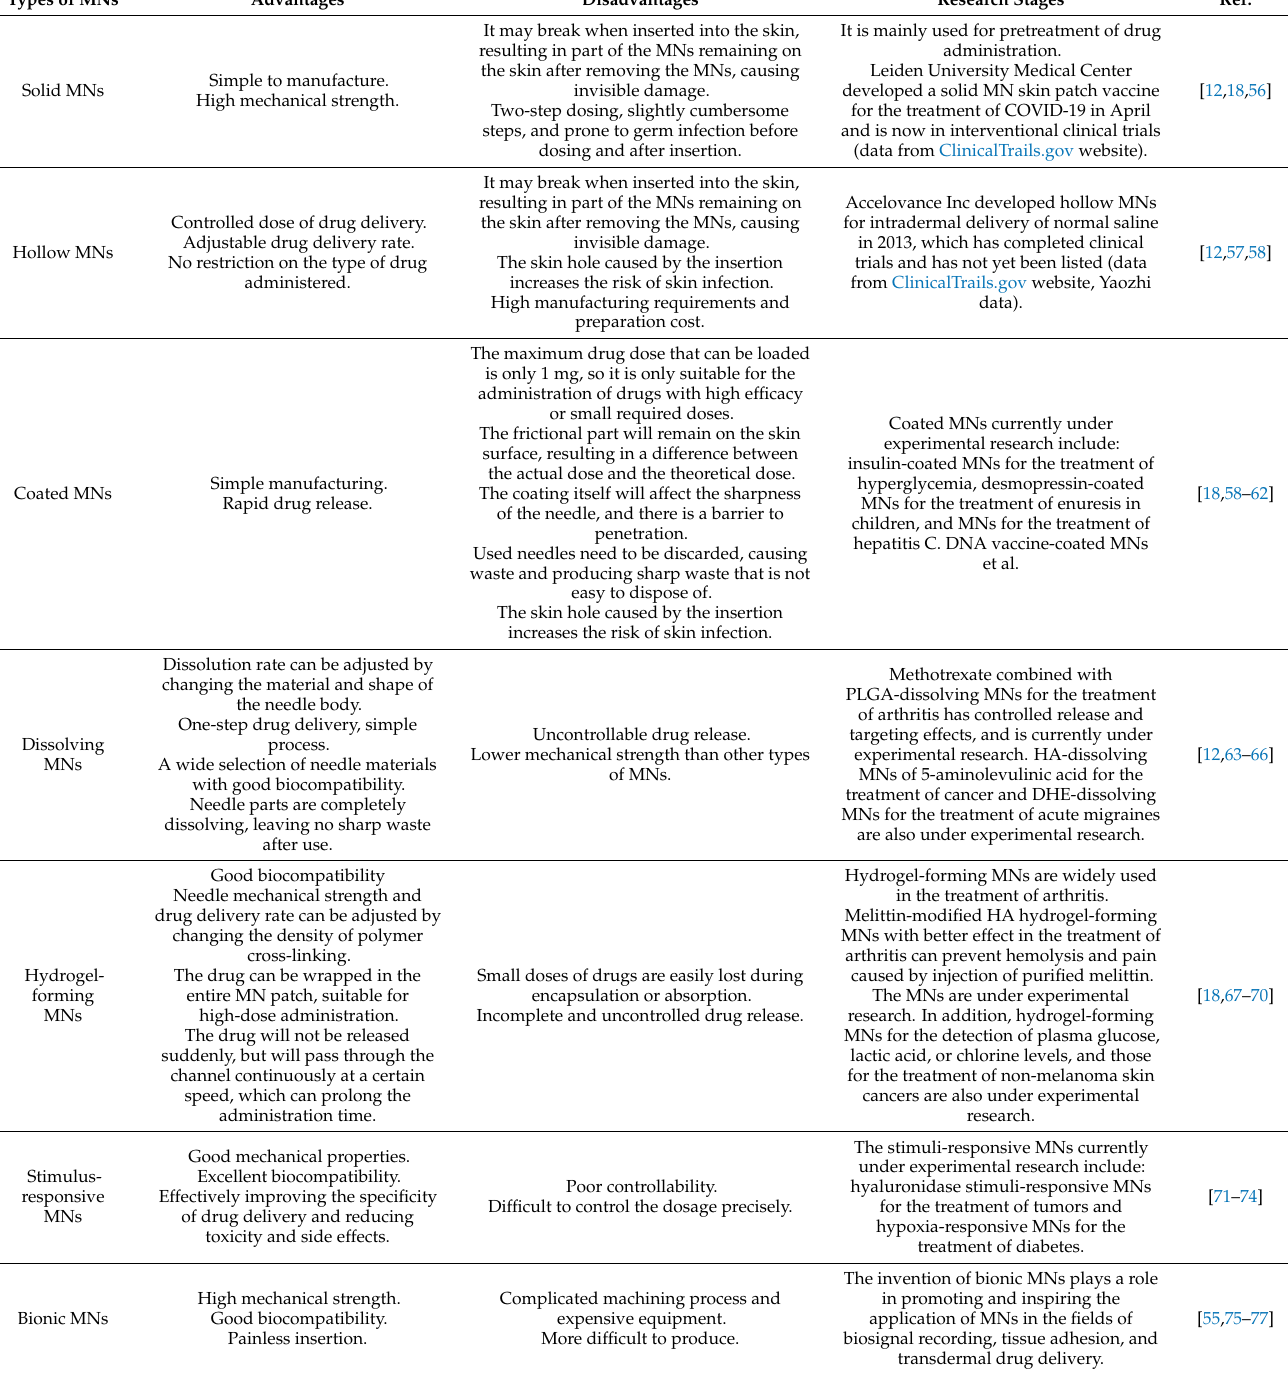
Table 3. Advantages, disadvantages, and research stages of different types of